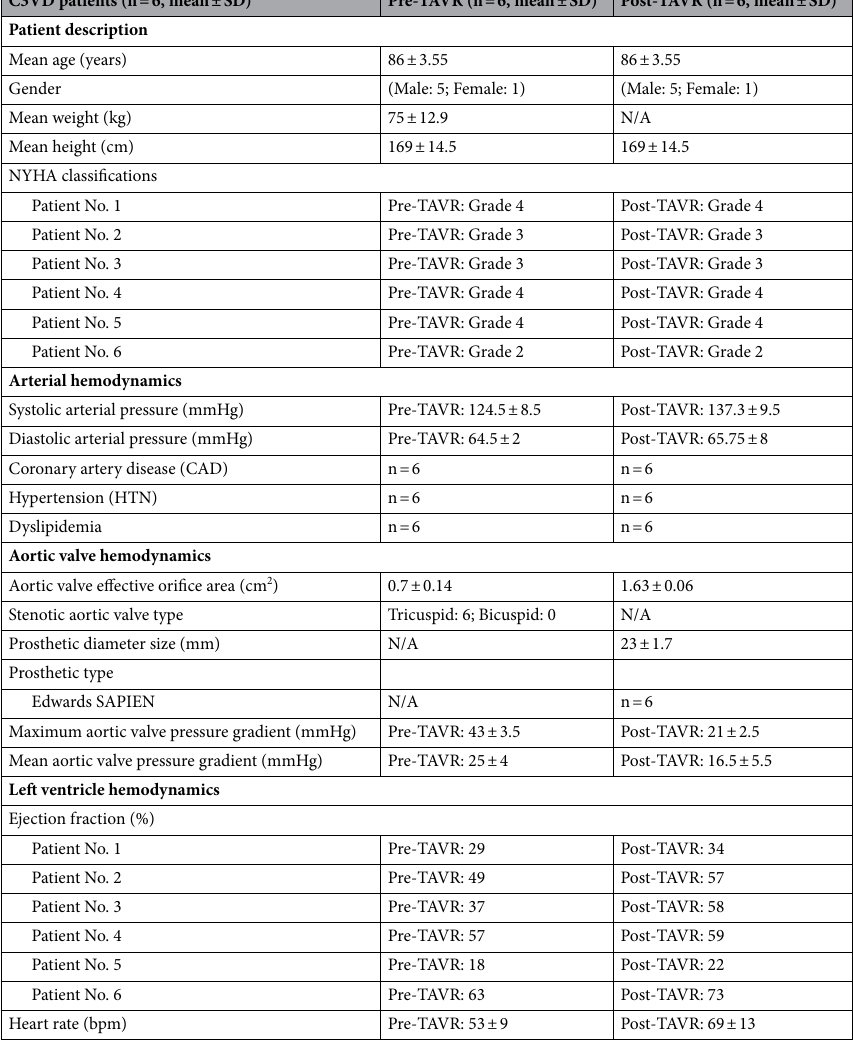
Table 1. Baseline and post-TAVR patient